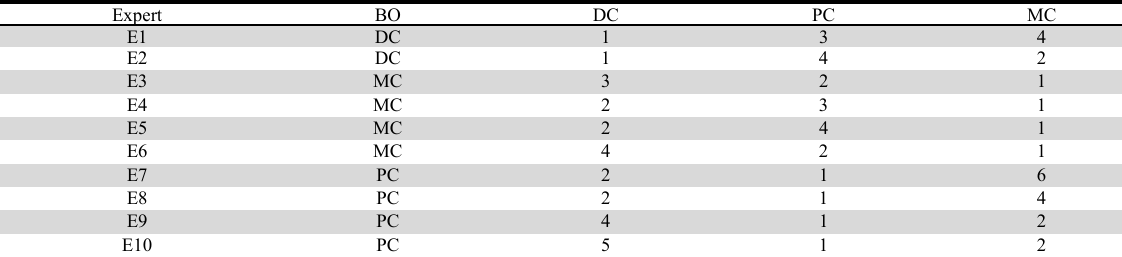
Main challenge preferences (Best to others) Expert